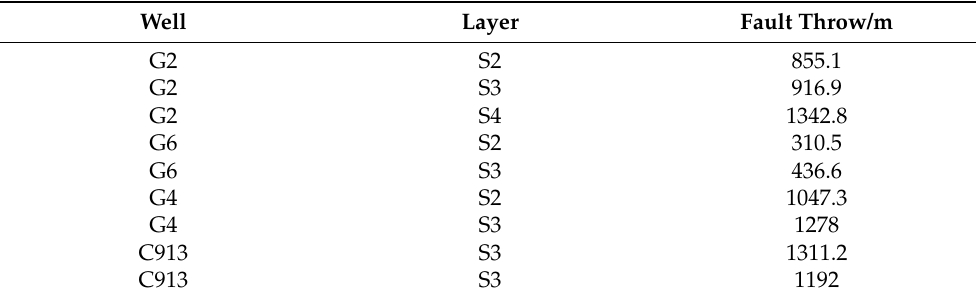
Table 4. Fault throw in the steep slope zone of the Guojuzi area.